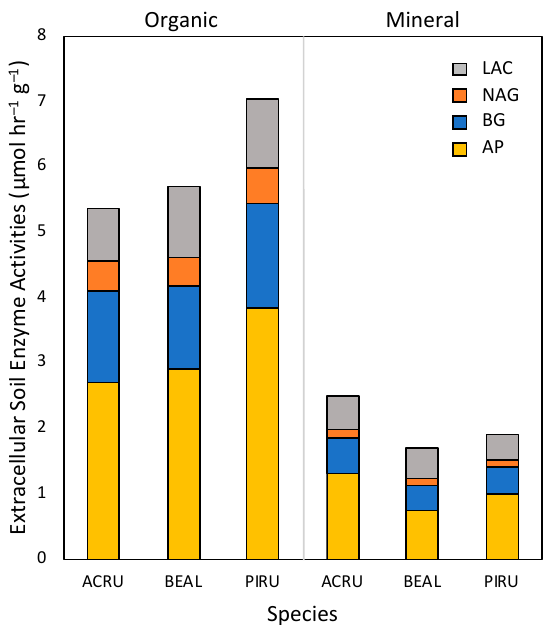
Figure 2. Extracellular soil enzymes (ESE) activities pooled across sites and sampling times by tree species for organic (left) and mineral (right) soil fractions. Stacked bars represent the mean activity for each enzyme for three replicate trees of each species assayed at four sites and at three times ( n = 36).